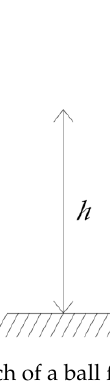
Figure 8. Sketch of a ball falling onto a rigid surface.